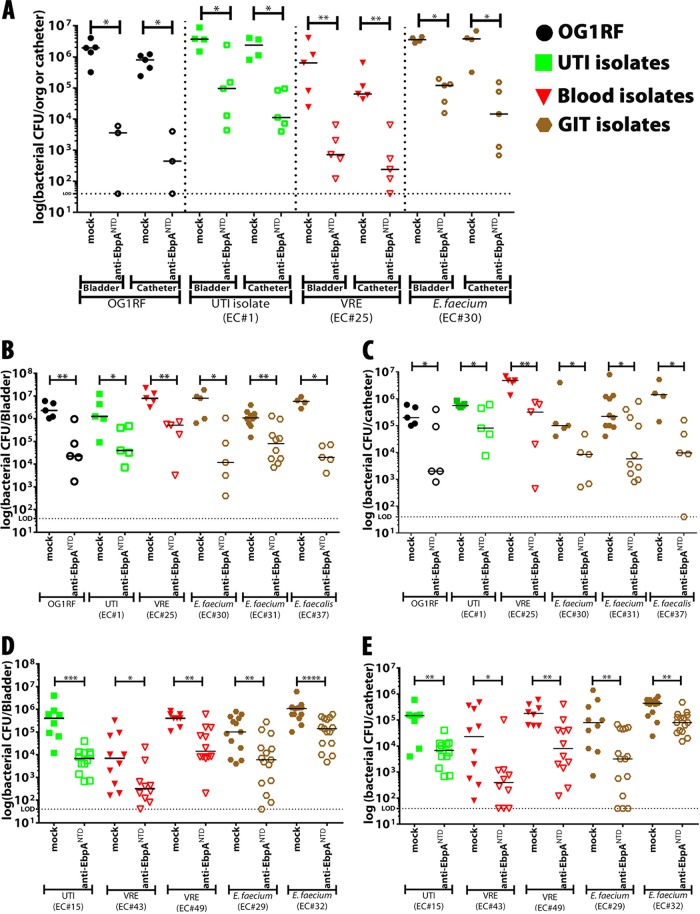
EbpANTD-based vaccine and anti-EbpANTD antibody treatment prevented and reduced bacterial titers of different enterococcal isolates. (A) Mice were immunized and received two booster immunizations with doses of 100 µg EbpANTD. Four weeks following the final immunization, mice were implanted with catheters and challenged with 2 × 107 CFU of E. faecalis OG1RF (n = 5) or with the indicated clinical enterococcal strains (n = 5). Following 24 h of infection, bacterial burdens in bladder tissue or recovered catheters were quantitated as the number of CFU recovered. org, organ. (B to E) To assess the therapeutic effect of anti-EbpANTD antibodies against enterococcus-infected mice, antibodies were administered intraperitoneally 12 hpi (anti-EbpANTD antibody titer of 1 × 107). Enterococcal strains were divided into two groups: (i) those that highly expressed EbpA and bound to Fg (B and C; n = 5) and (ii) those that did not express EbpA (n = 10 [EC#15 and EC#43] and n = 15 [EC#49]) or bind to Fg (D and E; n = 15) under in vitro conditions. Bladder (B) and catheter (C) bacterial burdens were quantified as described below. Values represent means ± SEM. The Mann-Whitney U test was used; P < 0.05 was considered statistically significant. *, P < 0.05; **, P < 0.005; ***, P < 0.0005; ns, values were not statistically significantly different. The horizontal bar represents the median value. The horizontal broken line represents the limit of detection of viable bacteria. Animals that lost the catheter were not included in this work.